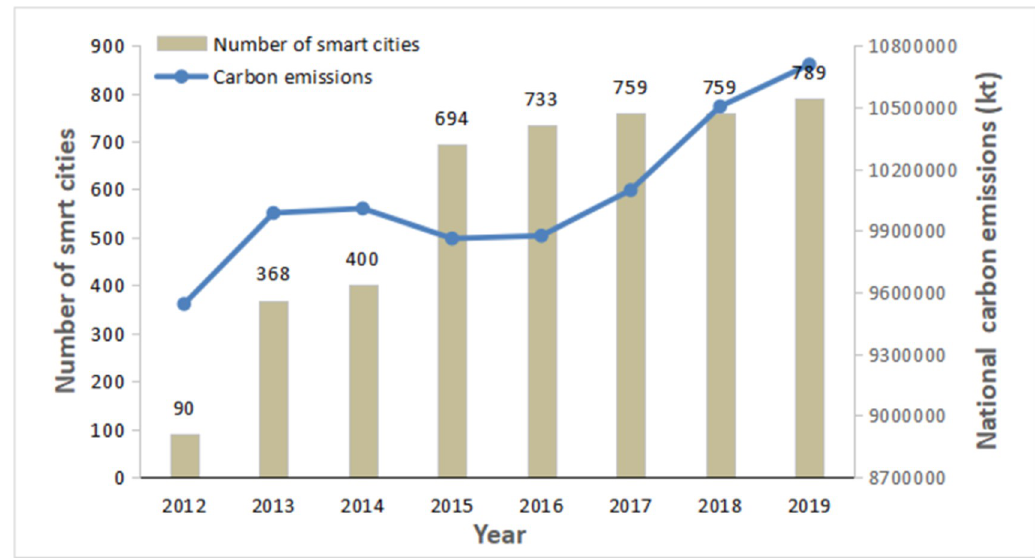
Fig 1. Number of smart cities and national carbon emissions in China. Source: Author´s design based on data from the Chinese government public information; Word Bank, 2022.